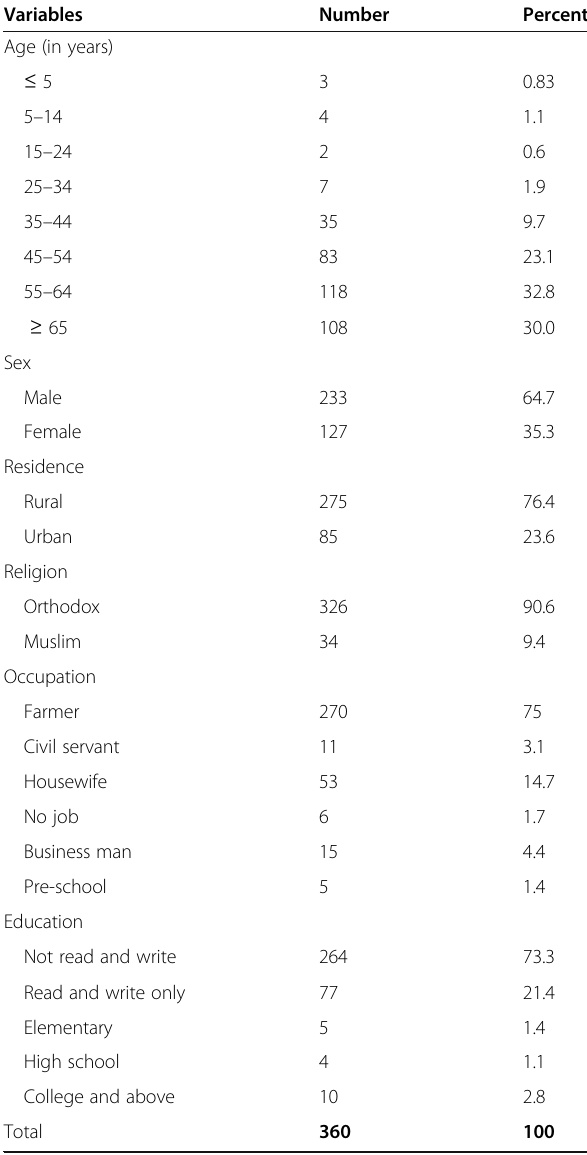
Table 1 Demographic characteristic of patients with EOIs